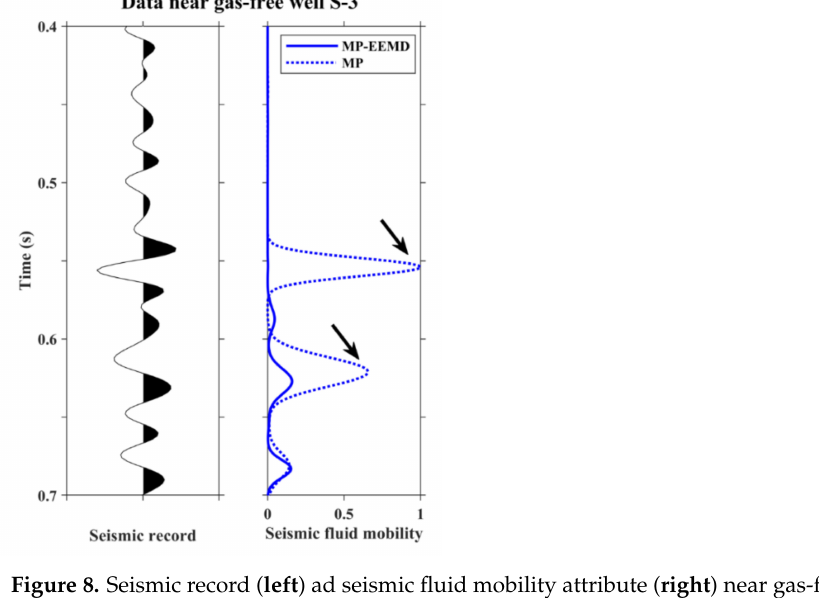
Figure 8. Seismic record ( left ) ad seismic fluid mobility attribute ( right ) near gas-free well